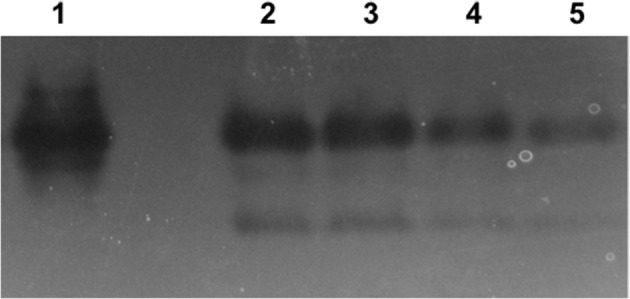
Superoxide dismutase (SOD) activity in native-PAGE. Lanes: 1. E. coli Mn SOD standard, 2. 800 μg/mL SeO3 + 1 μg/mL TeO3, 3. 800 μg/mL SeO3, 4. 1 μg/mL TeO3, 5. control (untreated cells). Lanes 2 through 5 loaded with 50 mg protein from soluble cell fraction.